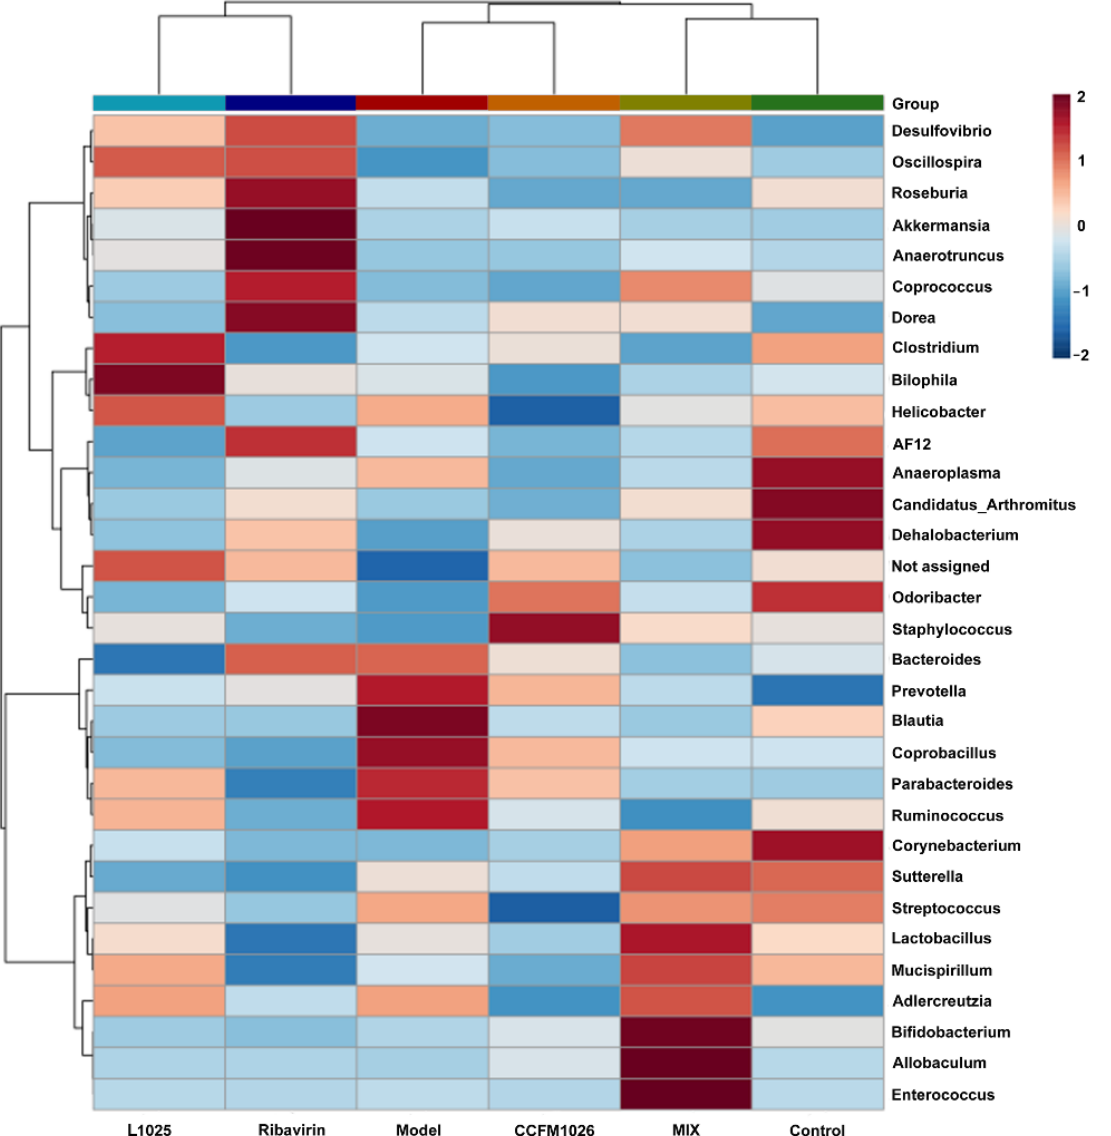
group, L. mucosae 1025, B. breve CCFM1026, and MIX treatments increased the concentra- tion of acetate and propionate although there was no statistical significance (Figure 8A). L. mucosae 1025 and B. breve CCFM1026 could not affect the butyrate production, but MIX treatment (3.9 ± 0.39) significantly increased the concentration of butyrate versus the model group. The results showed that probiotic treatments altered the metabolism of gut microbiota, and particularly, the mixture of L. mucosae 1025 and B. breve CCFM1026 sig- nificantly elevated the concentration of butyrate.